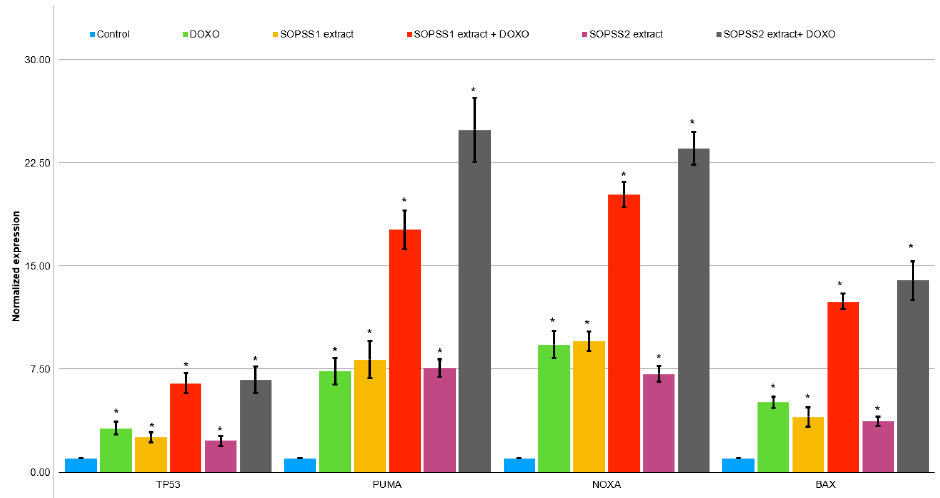
Figure 7. Expression analysis of apoptotic genes ( TP53 , PUMA , NOXA and BAX ) in NALM6 cells treated with IC 50 of SOPSS1 and SOPSS2 transgenic hairy root extracts, alone or co-treated with 250 nM doxorubicin, for 24 h. The gene expression was determined as described in RT-PCR methodology. Data presented as mean ± SD of at least three independent experiments. * p < 0.05 SOPPS1 or SOPSS2 alone or in combination with doxorubicin) vs. control.